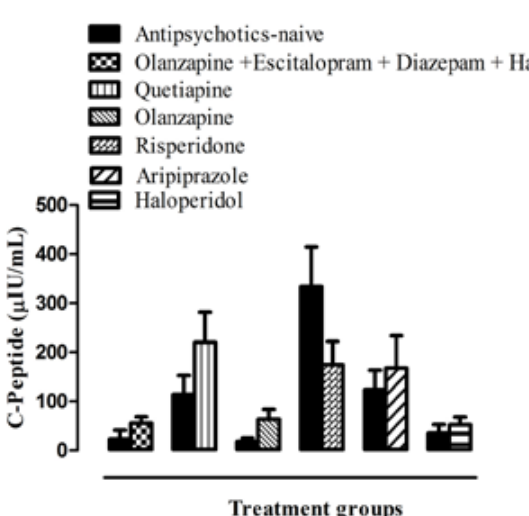
FIGURE 3 - Effect of selected antipsychotics on insulin: Antipsychotic-naïve patients were put on olanzapine in combination with esitalopram, diazepam (STAT, I.V) and haloperidol (STAT, I.M) (OLEDH, n=8), quetiapine (QUET, n=8), olanzapine (OLAN, n=8), risperidone (RISP, n=8), aripiprazole (n=8) or haloperidol (n=8) in therapeutic doses for an average time period of 39, 40, 45, 38, 30 and 33 days respectively showing no significant change in insulin as compared to antipsychotics-naïve patients (ANOVA followed by Bonferroni’s Multiple Comparison Test) (P > 0.05).